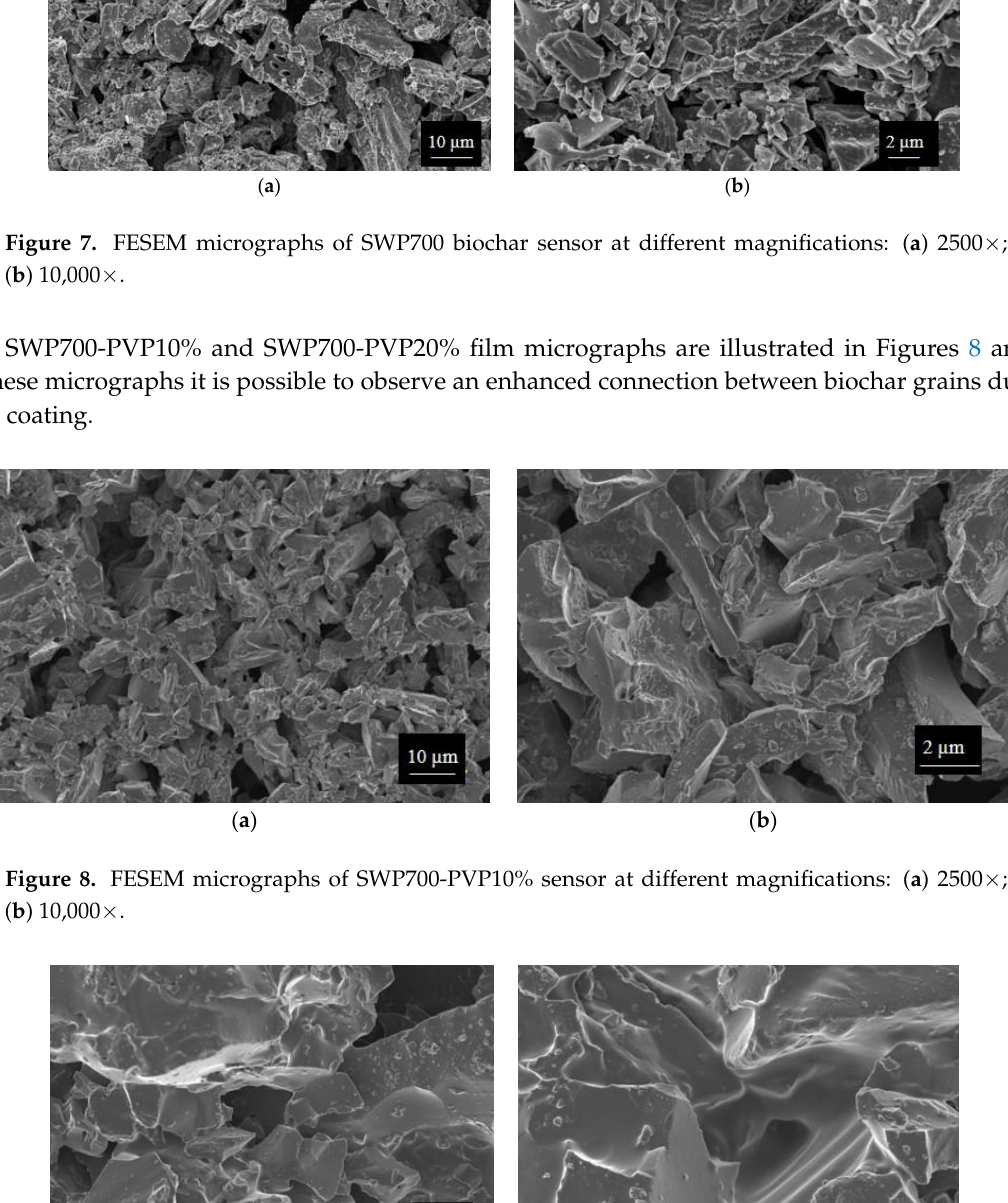
Figure 9. FESEM micrographs of SWP700-PVP20% sensor at different magnifications: ( a ) 2500×; ( b ) 10,000×.